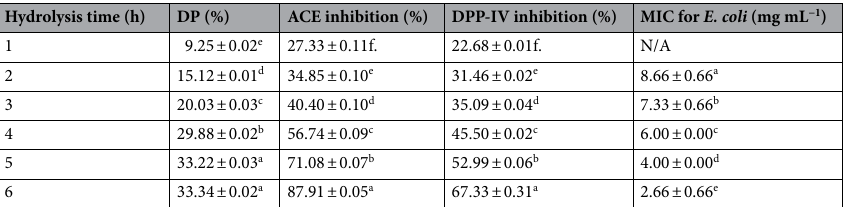
Table 1. Biological activities of gelatin hydrolysates (1 mg mL -1 ). Data are shown as mean ± standard error of three replicates. Different superscript letters in the same column represent the significant difference ( P < 0.05). ACE, angiotensin-converting enzyme; DP, degree of depolymerization; DPP-IV, dipeptidyl peptidase IV; MIC, minimum inhibitory concentration; N/A, mean not applicable.